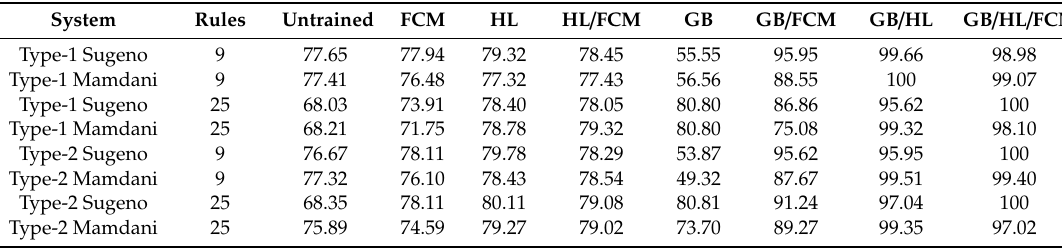
Table 2. ‘%Bars ± 20 ◦ C’ of the fuzzy systems